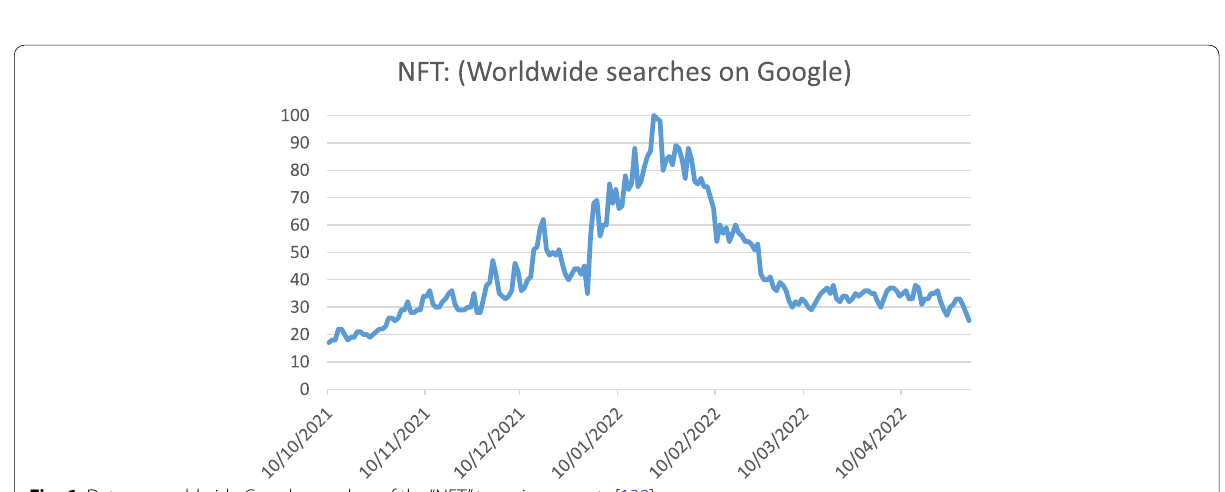
Fig. 6 Data on worldwide Google searches of the “NFT” term, in percents